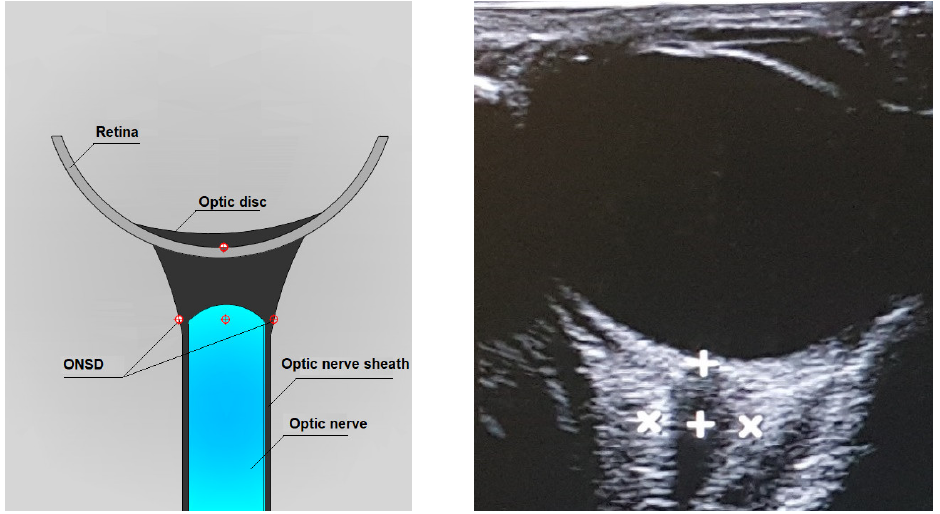
Figure 3. Axial lateral transbulbar approach ONSD measurement.